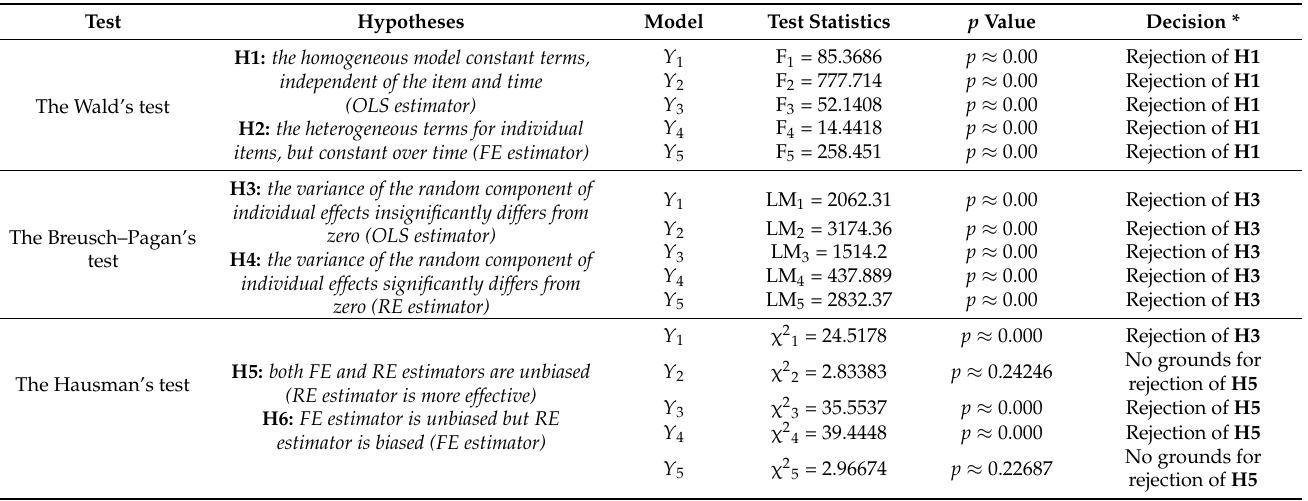
Table 5. The result of the Wald, Breusch–Pagan, and Hausman